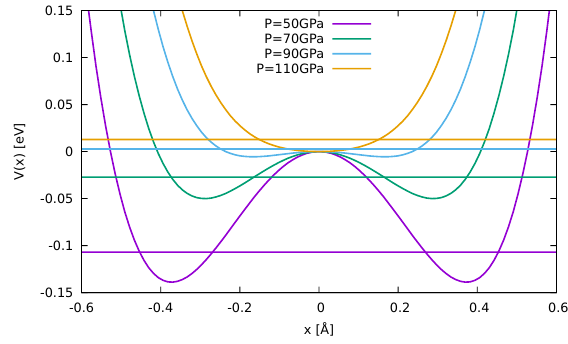
Figure 1. The structure of ice VII for pressures P < 65 GPa. Oxygen atoms (in red) form a body-centered cube, while the hy- drogen atoms (light blue) are located between the oxygen atoms in an asymmetric position. The thin dashed lines represent weak hydrogen bonds, while the bond with the nearest oxygen atom is covalent. Each oxygen atom has 2 hydrogen neighbours (only 2 are represented on the figure, the others associated with the other oxygen atoms have been omitted for clarity).